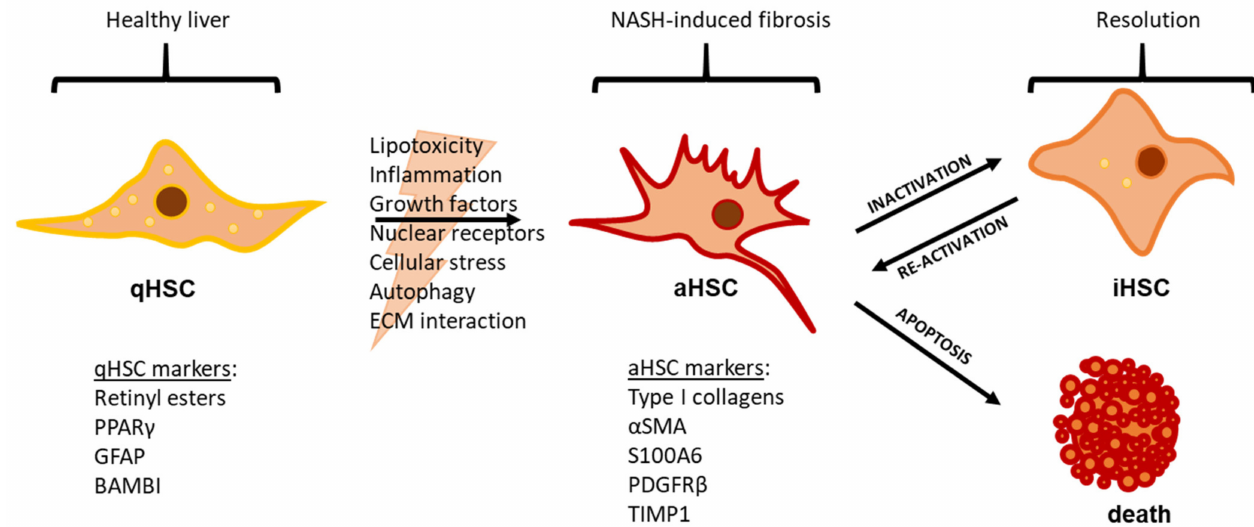
Figure 2. The hepatic stellate cell phenotypic switch in NASH. In a healthy liver, the hepatic stellate cell (HSC) rests in a quiescent state (qHSC) while residing close to the hepatic sinusoids. qHSCs are considered dormant and non-proliferative, and they are characterized by the cytoplasmatic storage of retinyl esters (vitamin A) in lipid droplets; markers include PPAR γ , GFAP, and BAMBI, all expressed in the qHSCs. The accumulation of lipotoxic metabolites, inflammation, and oxidative stress in NASH affects multiple hepatic cell types and leads to the release/activation of several cellular signaling factors, such as growth factors (e.g., increased TGF β , PDGF, and connective tissue growth factors) and nuclear receptors (e.g., decreased PPAR γ and retinoid X receptor activation), thus promoting an HSC phenotypic switch. In this process, qHSCs lose their stored retinyl esters and transdifferentiate into the activated, proliferative, and contractile state (aHSC). aHSCs are characterized by the production of pro-collagens for extracellular matrix deposition and the promotion of HSC activation and fibrogenesis (thus creating a positive feedback loop), as well as the ability to migrate and divide; markers include the expression of α SMA, S100a6, PDGFR β , and TIMP1. The clearance of aHSCs is necessary for the cessation of matrix deposition, and it can take place through apoptosis or through inactivation. Inactivated HSCs (iHSCs) differentiate towards a more dormant phenotype (e.g., with a decrease of aHSC characteristics and the re-establishment of the cytoplasmic storage of retinyl esters), but they do not completely revert to the qHSC state and have increased sensitivity toward reactivation. aHSC: activated hepatic stellate cell; BAMBI: bone morphogenetic protein and activin membrane bound inhibitor; ECM: extracellular matrix; GFAP: glial fibrillary acidic protein; iHSC: inactivated hepatic stellate cell; PDGFR β : platelet derived growth factor receptor β ; PPAR γ : peroxisome proliferator activated receptor γ ; qHSC: quiescent hepatic stellate cell; S100a6: S100 calcium-binding protein A6; TGF β : transforming growth factor beta; TIMP1: tissue inhibitor of metalloproteinase 1; α SMA: alpha smooth muscle